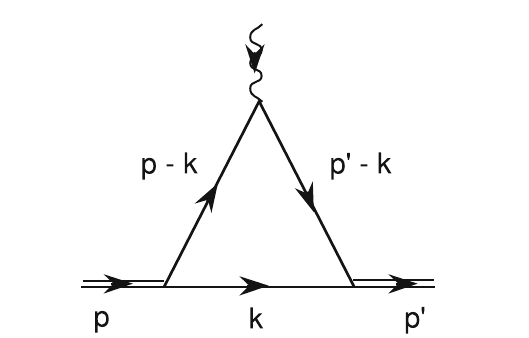
Fig. 10 Feynman diagram for the electromagnetic form factor